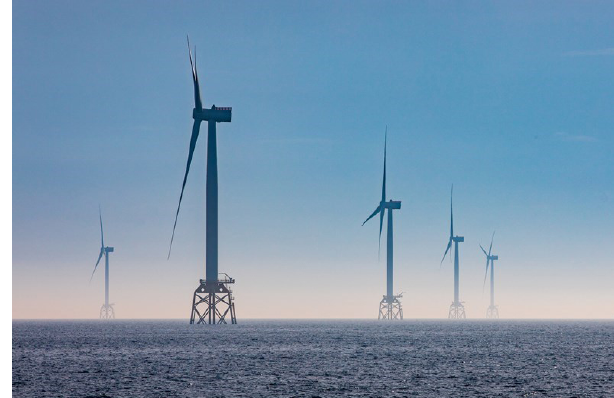
Figure 1. Visibility of wind turbines offshore. The wind turbines are forming an optical contrast against a clear sky with moderate mist near the sea surface, which reduces visibility for the lower parts of the wind turbines. Photo from SSE